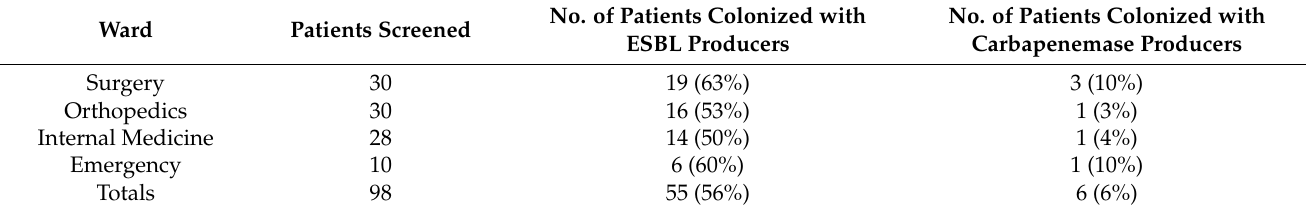
Table 2. Rates of colonization with ESBL or carbapenemase producers by